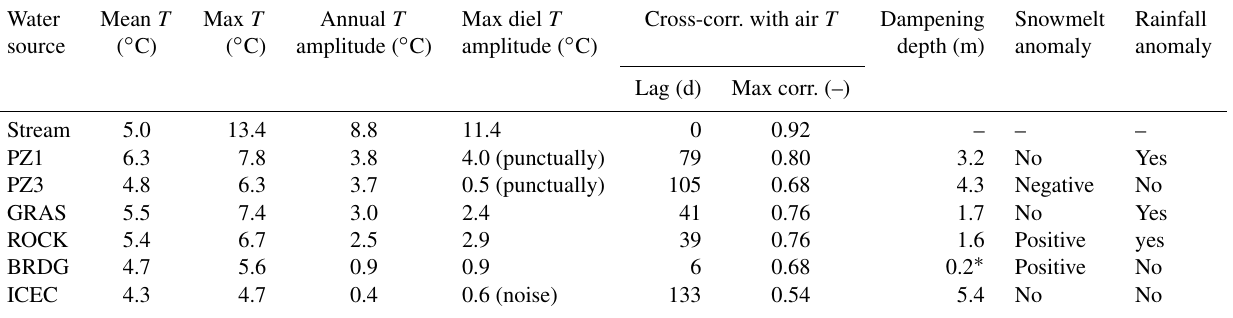
Table 1. Statistics of temperature time series recorded in the stream, piezometers and springs. The dampening depth estimated for the BRDG spring ( ∗ ) is biased because of a positive anomaly of temperature due to snowmelt input (see text). Water